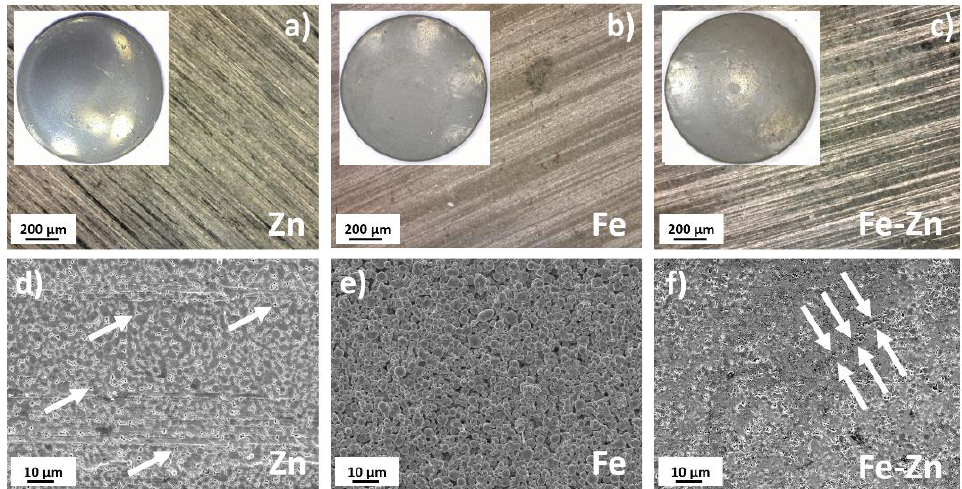
Figure 3. Macroscopic optical photographs of Zn ( a ), Fe ( b ) and Fe-Zn ( c ) samples with the corre- sponding micrographs showing the material surface in detail ( d – f ). White arrows point at the local defects and cracks that appeared after compression.